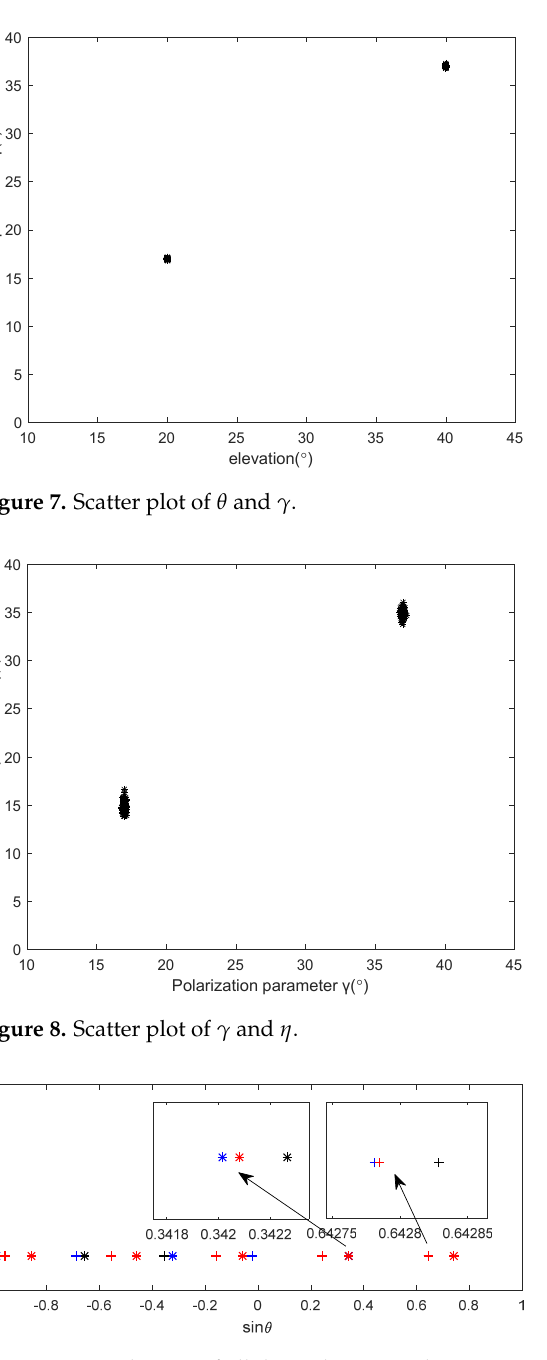
Figure 9. Distribution of all the ambiguity values.